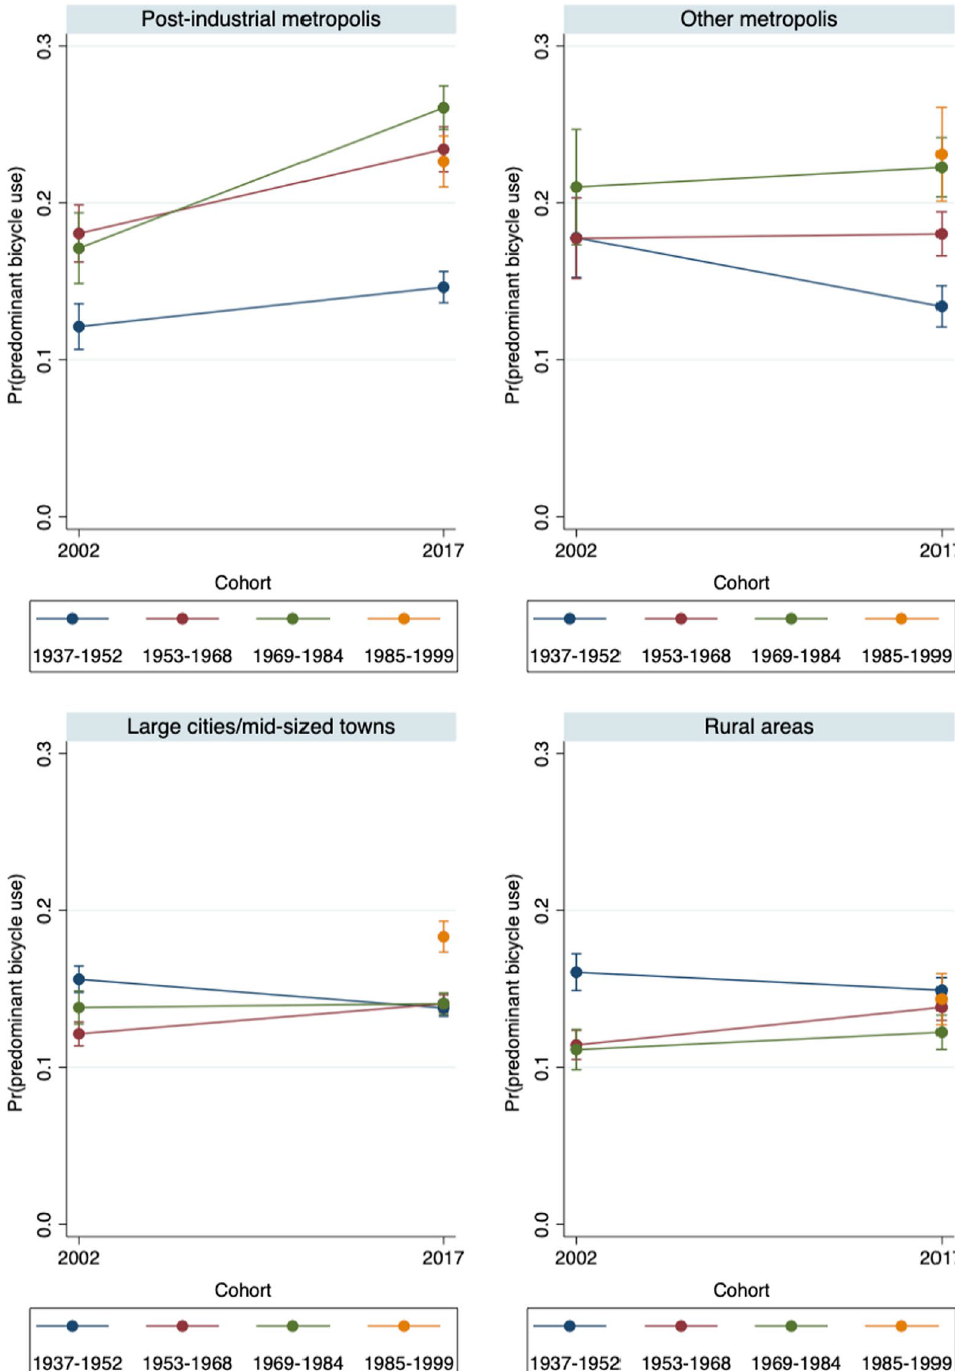
Fig. 3 Predicted probabilities of predominant regular bicycle use in 2002 and 2017 – by settlement type (Model 1). Source: Mobility in Germany: MiD person-time-series dataset (own calculations). Note : Predominant bicycle use is defined as (almost) daily bicycle use and car use of at most 1 to 3 times per week. Survey weights are applied. See also Table 5 for main effects and standard